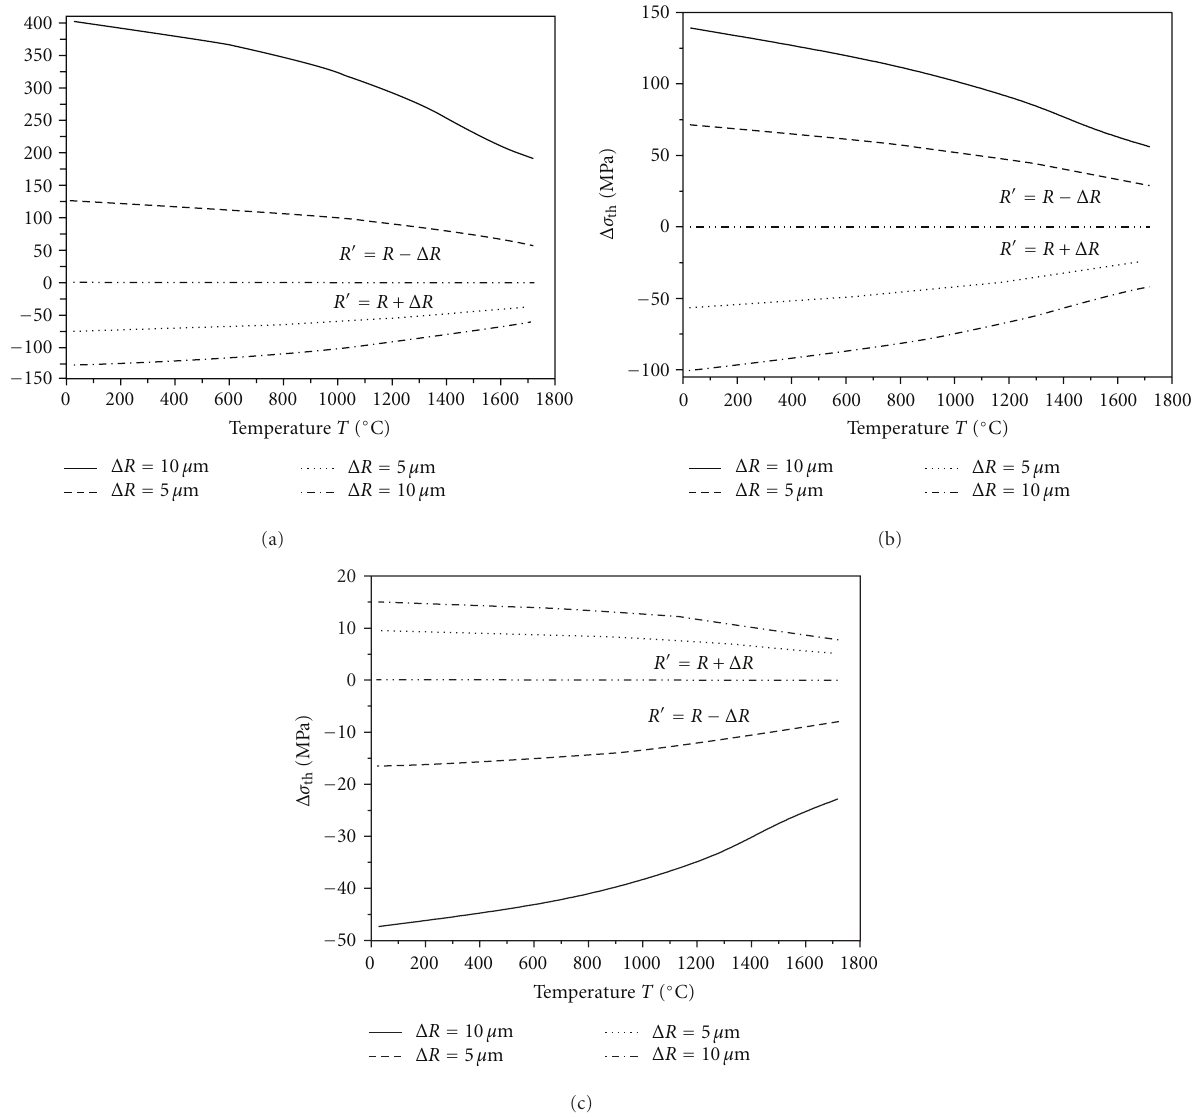
Figure 4: (a) Δ σ th - T curves for di ff erent SiC particle size di ff erences ( R = 15 μ m, s = 0 . 0385 μ m), (b) Δ σ th - T curves for di ff erent SiC particle size di ff erences ( R = 15 μ m, s = 38 . 5 μ m), and (c) Δ σ th - T curves for di ff erent SiC particle size di ff erences ( R = 15 μ m, s = 385 μ